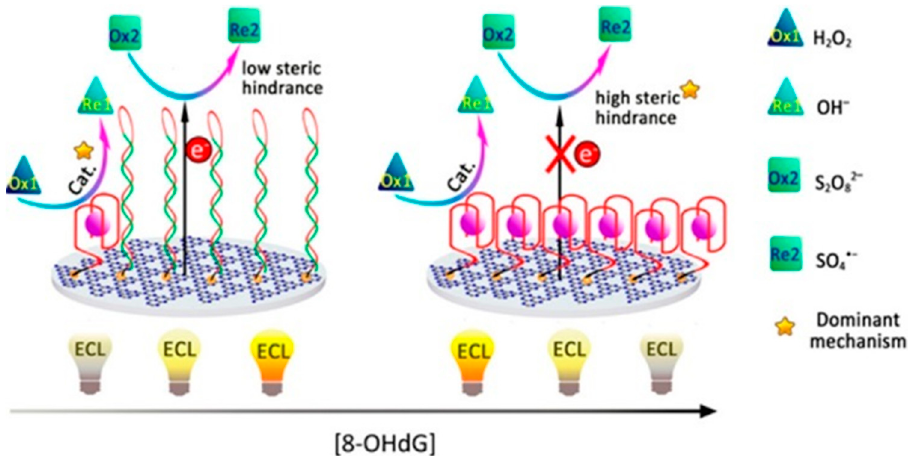
Figure 7. Electrochemiluminescent (ECL) biosensor developed by Lv et al. [35]. Reprinted with permission from Reference [35]. © 2019, American Chemical Society.